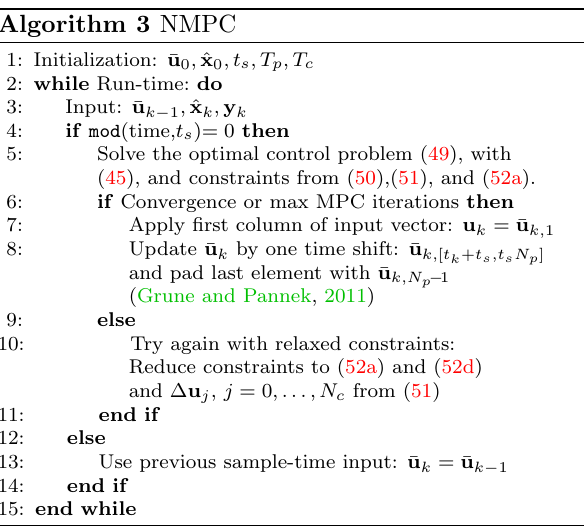
Algorithm 3 NMPC